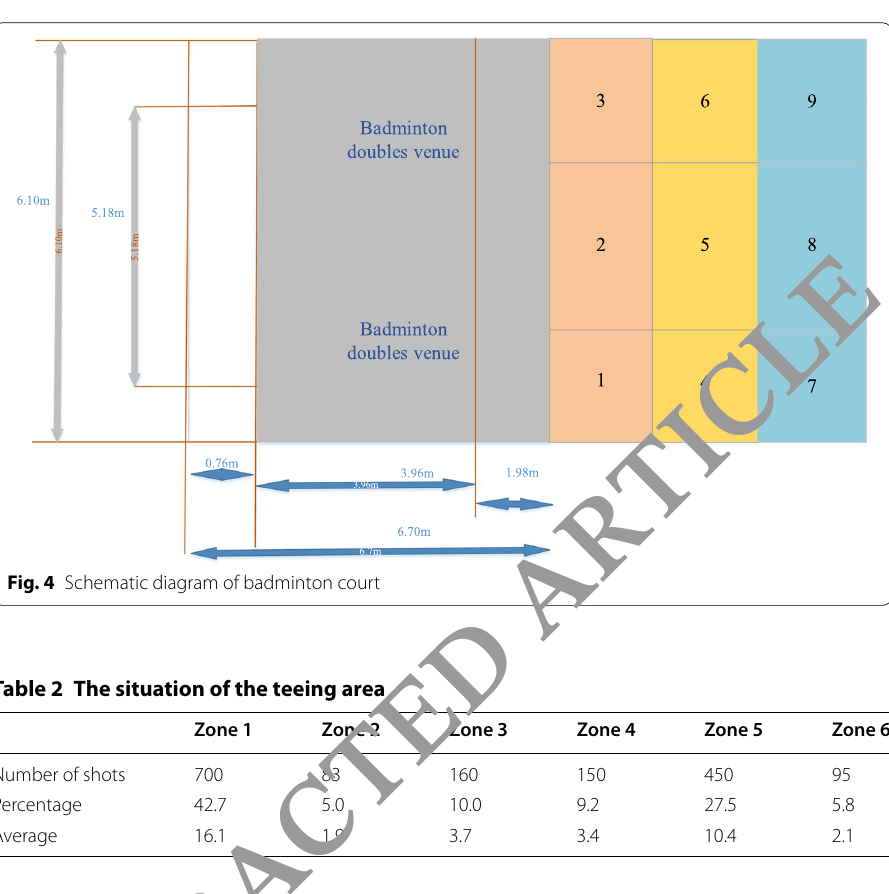
Table 2 The situation of the teeing area Zone 1 Zone 2 Zone